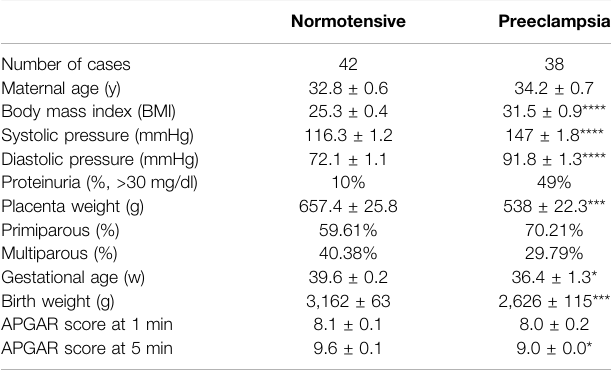
TABLE 1 | Clinical characteristics of study subjects with and those without